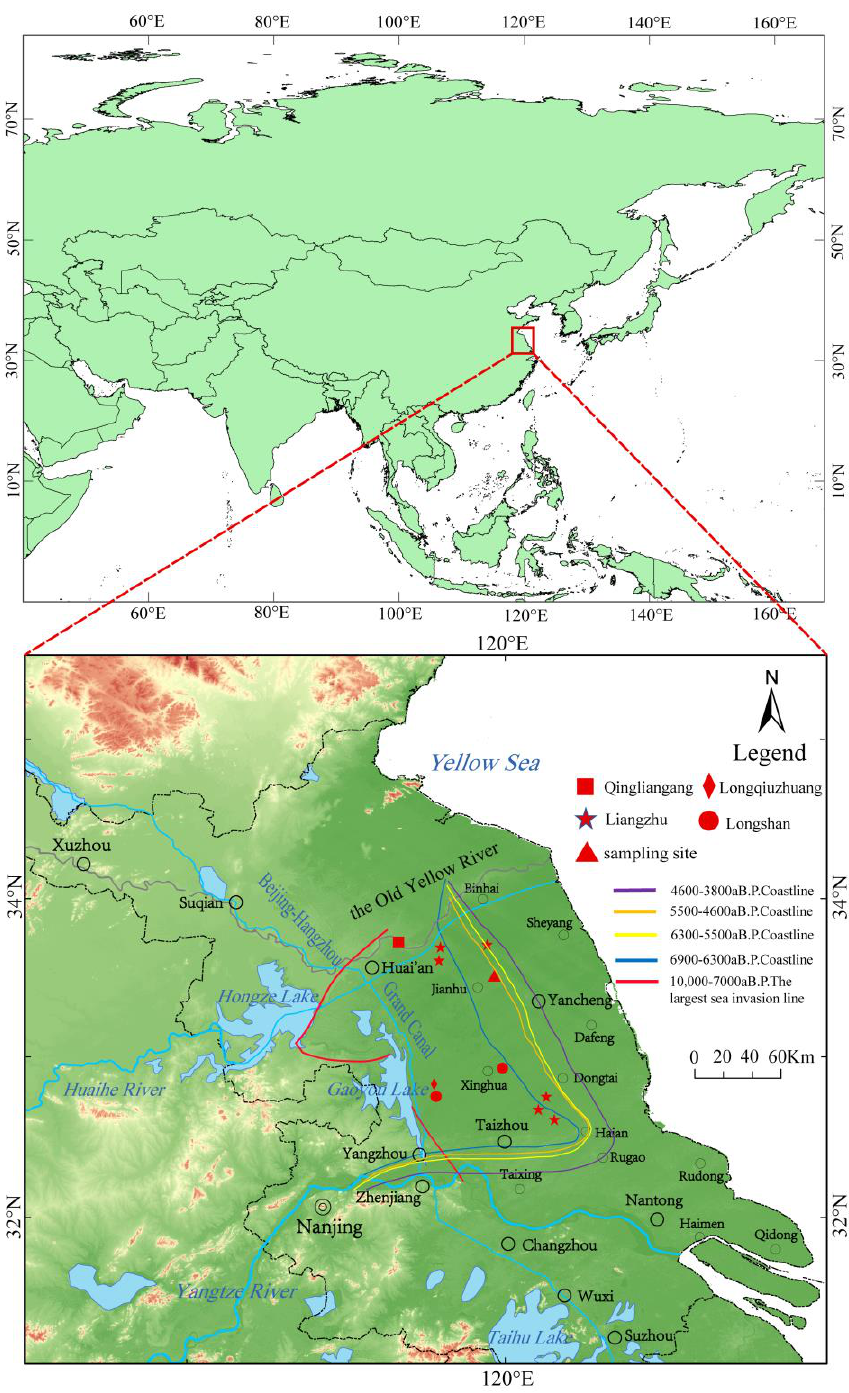
Figure 1. Location of the study area and the coastline in different periods.